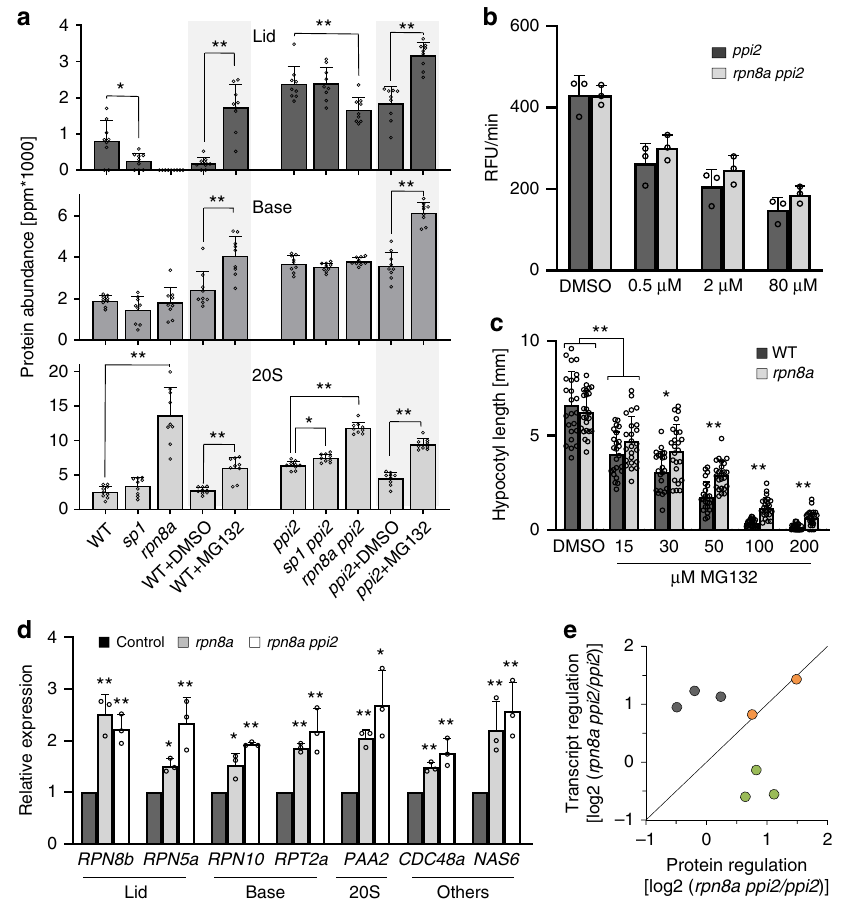
Fig. 6 Characterization of proteasome accumulation and activity. a Quantitative determination of proteasome subunits by proteome-wide protein quanti fi cation 18 of the indicated genotypes and after the indicated treatment (DMSO control, + MG132). The ppm values for all subunits belonging to the lid (upper panel), the base (middle panel) and the 20S catalytic core (lower panel) from three biological and three technical replicates were summed up and the results are presented along with their standard deviation (SD). The annotation of subunits to the lid , the base and the core is as published previously 17 . Signi fi cant differences are indicated with one ( p -value < 0.05, T -test, two-sided) or two ( p -value < 0.01) stars (two-sided T -test). b Chymotrypsin activity of the proteasome reported in RFU/min as determined from extracts of ppi2 and rpn8a ppi2 mutants (error-bars represent SD, note that the differences are not signi fi cant). c Hypocotyl length determination from wildtype and rpn8a single mutants from 5-day old etiolated seedlings, presented as the mean from 24 plants, grown in the presence of the indicated amount of MG132 (error-bars represent SD). Signi fi cant differences are indicated with one ( p -value < 0.005) or two ( p -value < 0.001) stars (two-sided T -test). d Quantitative real-time transcript abundance determination for different lid , base , 20S subunits and regulatory components ( “ other ” ) from wildtype and rpn8a mutant plants. Error-bars represent SD. Signi fi cant differences are indicated with one ( p -value < 0.05) or two ( p -value < 0.01) stars (two-sided T -test). e Relationship between transcriptional regulation ( y -axis: Log2-transcript ratio from the double mutant in relation to the ppi2 single mutant) and protein abundance ( x -axis: Log2-protein abundance ratio from the double mutant in relation to the ppi2 single mutant) for three proteasome subunits (gray), two regulatory factors (orange) and three photosynthetic proteins (green) for